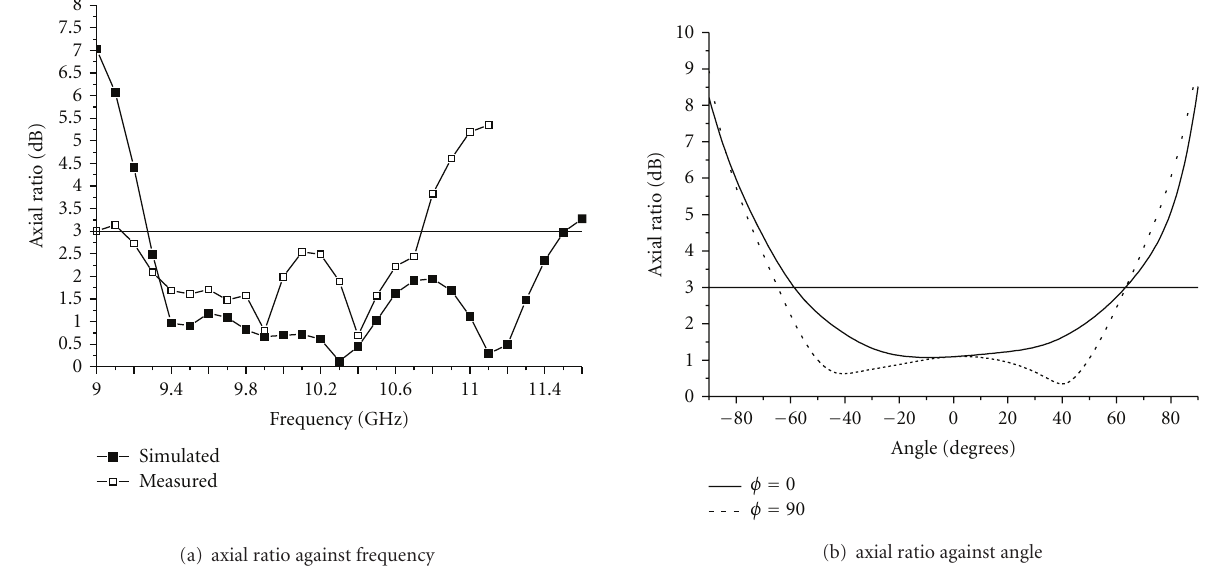
Figure 3: Simulated and measured axial ratio.